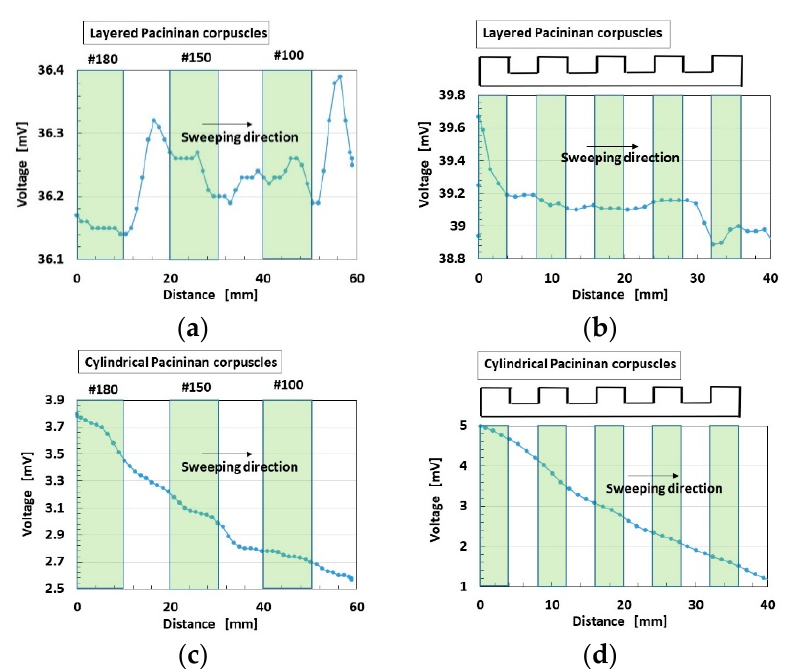
Figure 10. Experimental results of built-in voltage by shear force: ( a ), ( b ) for layered Pacinian corpuscles; ( c ), ( d ) for cylindrical Pacinian corpuscles; ( a ), ( c ) on intermittently positioned sandpaper; ( b ), ( d ) on a convex/concave-shaped body.